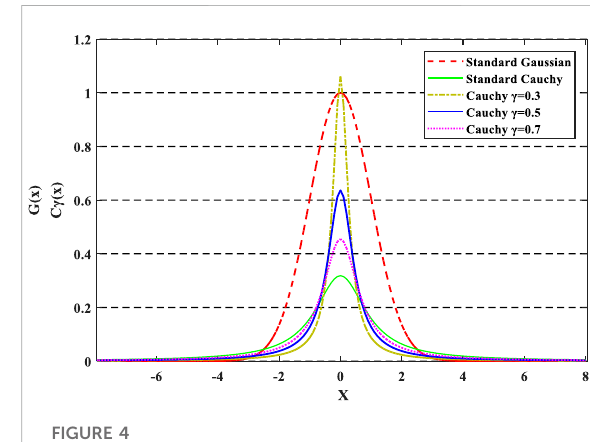
FIGURE 2 S ( α ) function curve.